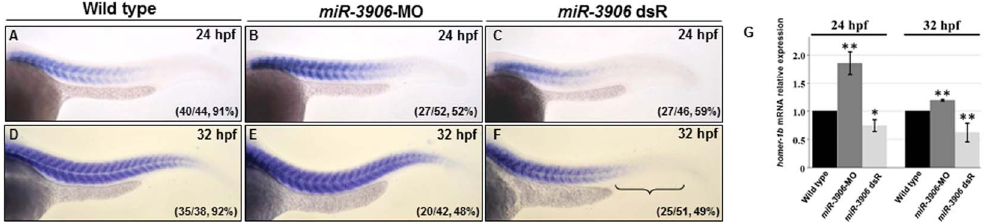
Figure 3. Change of miR-3906 level affected the amount of homer-1b mRNA in zebrafish embryos. ( A , D ) Compared with WT, injection of miR-3906 -MO increased the expression level of homer-1b mRNA in embryos at 24 hpf ( A vs . B ) and 32 hpf ( D vs . E ). Injection of miR-3906 dsR (mature double-strand miR-3906 ) reduced the expression level of homer-1b mRNA in the front of trunk muscle and was absent in the tail region at 24 hpf ( A vs . C ) and 32-hpf ( D vs . F ). ( G ) The expression levels of homer-1b in WT embryos, miR-3906 -MO-injected embryos and miR-3906 dsR-injected embryos at 24 hpf and 32 hpf were quantified. Each one was carried out with 100 embryos, and triplicate experiments were performed (n=3). The numbers shown in the lower-right corner of panels A–F indicate the number of phenotypes out of the total number of embryos examined. SigmaPlot software was used to perform Student’s t -test. *: indicates the difference at P , 0.05 level; **: indicates the difference at P , 0.01 level.